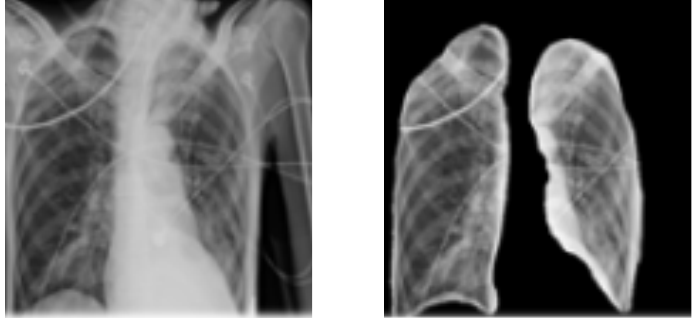
Figure 5. The pipeline of the proposed method. First, the lungs are segmented, then robust visual features are extracted. Features are modelled using the proposed mixture model (SSDDMM) and a Bayesian framework is applied to estimate the parameters of the model. Finally, images are classified on the basis of Bayes rule.